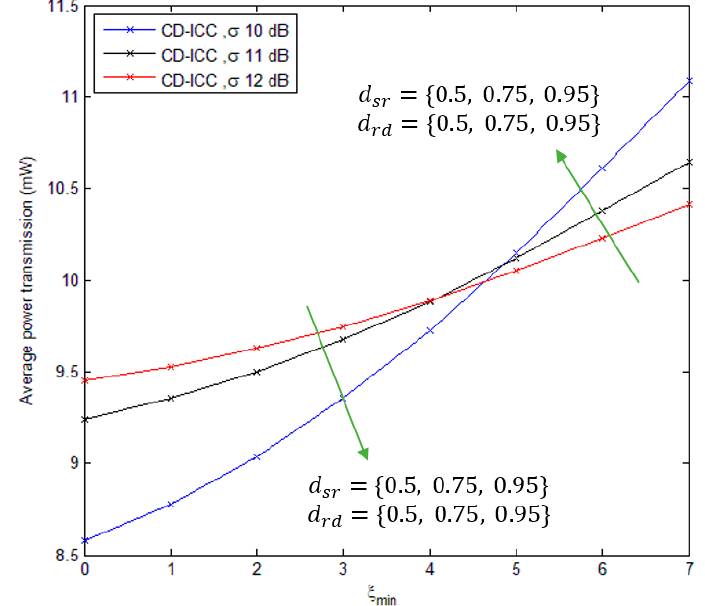
Figure 10. Average power transmission of CD-ICC with 𝜉 (cid:3040)(cid:3036)(cid:3041) . In all cases, 𝑑 (cid:3046)(cid:3031) is 1 , 𝜎 is 12 dB and 𝜌 is 3.